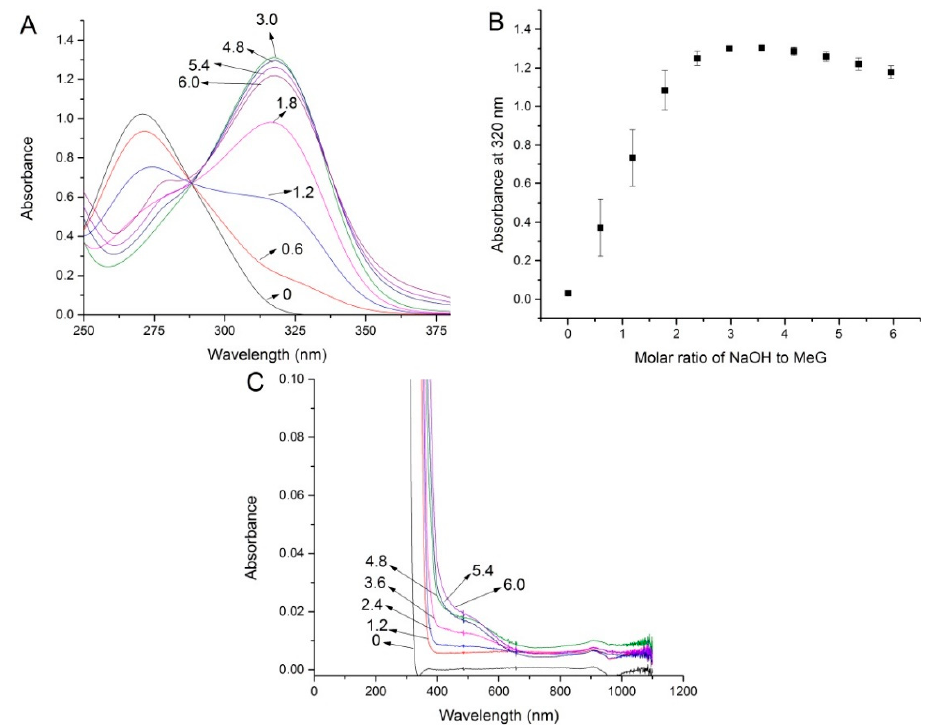
Figure 2. ( A ) UV-visible (UV-vis) spectra of methyl gallate solution continuously titrated with NaOH solution; ( B ) the absorbance changes at 320 nm, data are presented as mean ± SD; ( C ) the spectra changes at around 500 nm indicate a certain degree of oxidation of MeG; [NaOH]/[MeG] molar ratio are indicated on spectra.